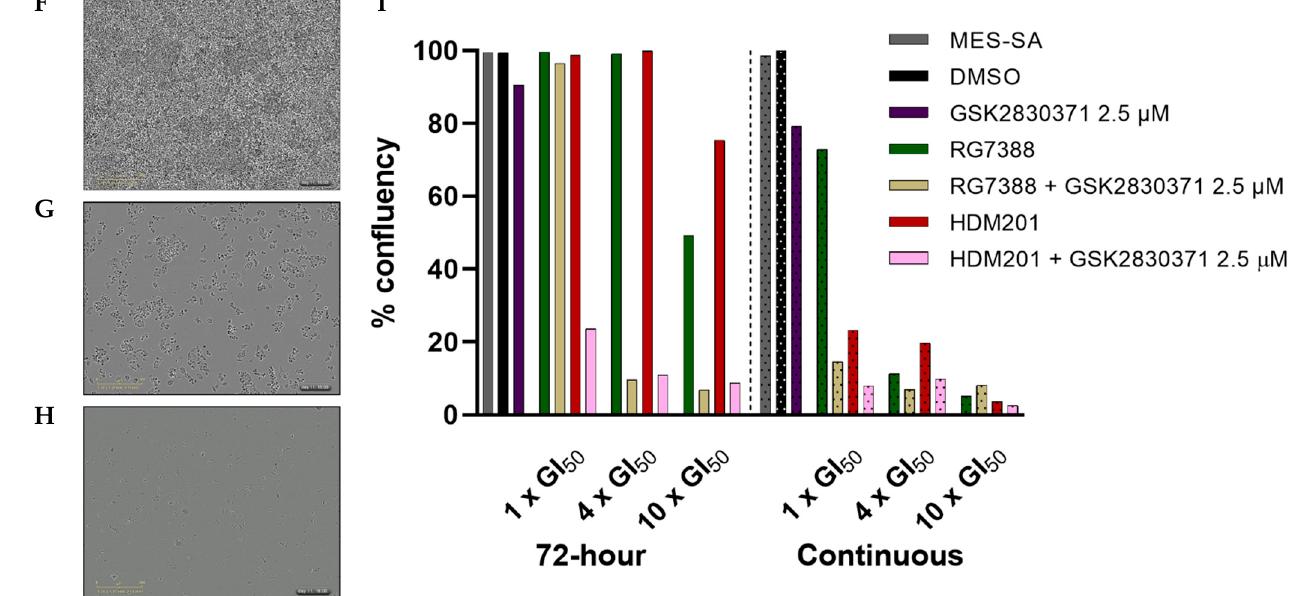
Figure 6. Images and confluency data captured using the IncuCyte incubator camera system. MES-SA cells were treated with drug for either 72 h or continually dosed for 288 h. Medium was replaced every 72 h and phase contrast images taken every 4 h. Growth curves for ( A ) RG7388; ( B ) HDM201; ( C ) GSK2830371; ( D ) RG7388 + GSK2830371; ( E ) HDM201 + GSK2830371, with solid lines representing 72 h treatment and dashed lines continual treatment; representative phase contrast images taken on day 11 at 18:00 h for ( F ) DMSO treatment for 72 h; ( G ) RG7388 at 10 × GI 50 concentration for 72 h; ( H ) RG7388 at 10 × GI 50 + 2.5 µM GSK2830371 treatment for 72 h; ( I ) percentage confluency of each well following either 72 h or continual treatment with 1, 4 or 10 × GI 50 concentrations of RG7388 or HDM201, alone or in combination with 2.5 µM GSK2830371. Percentage confluency of each well was calculated using an integrated confluence algorithm and reflects both cell number and area of the well covered by cells.